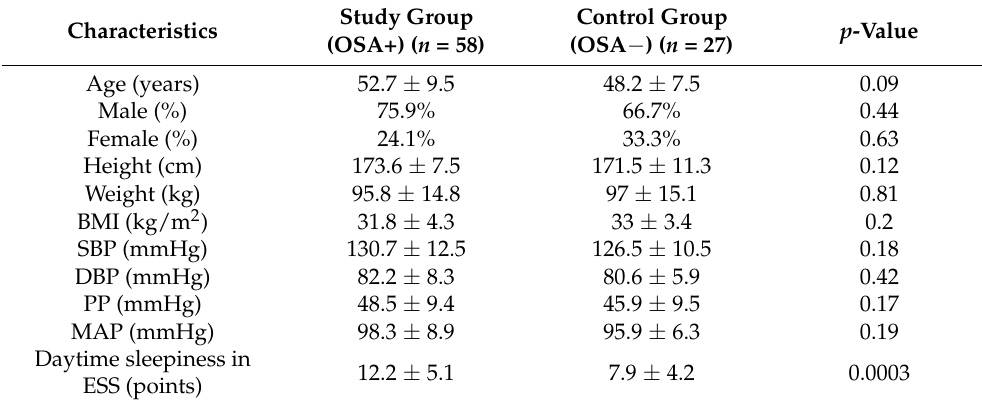
Table 1. General characteristics of study (OSA+) and control (OSA − ) groups.